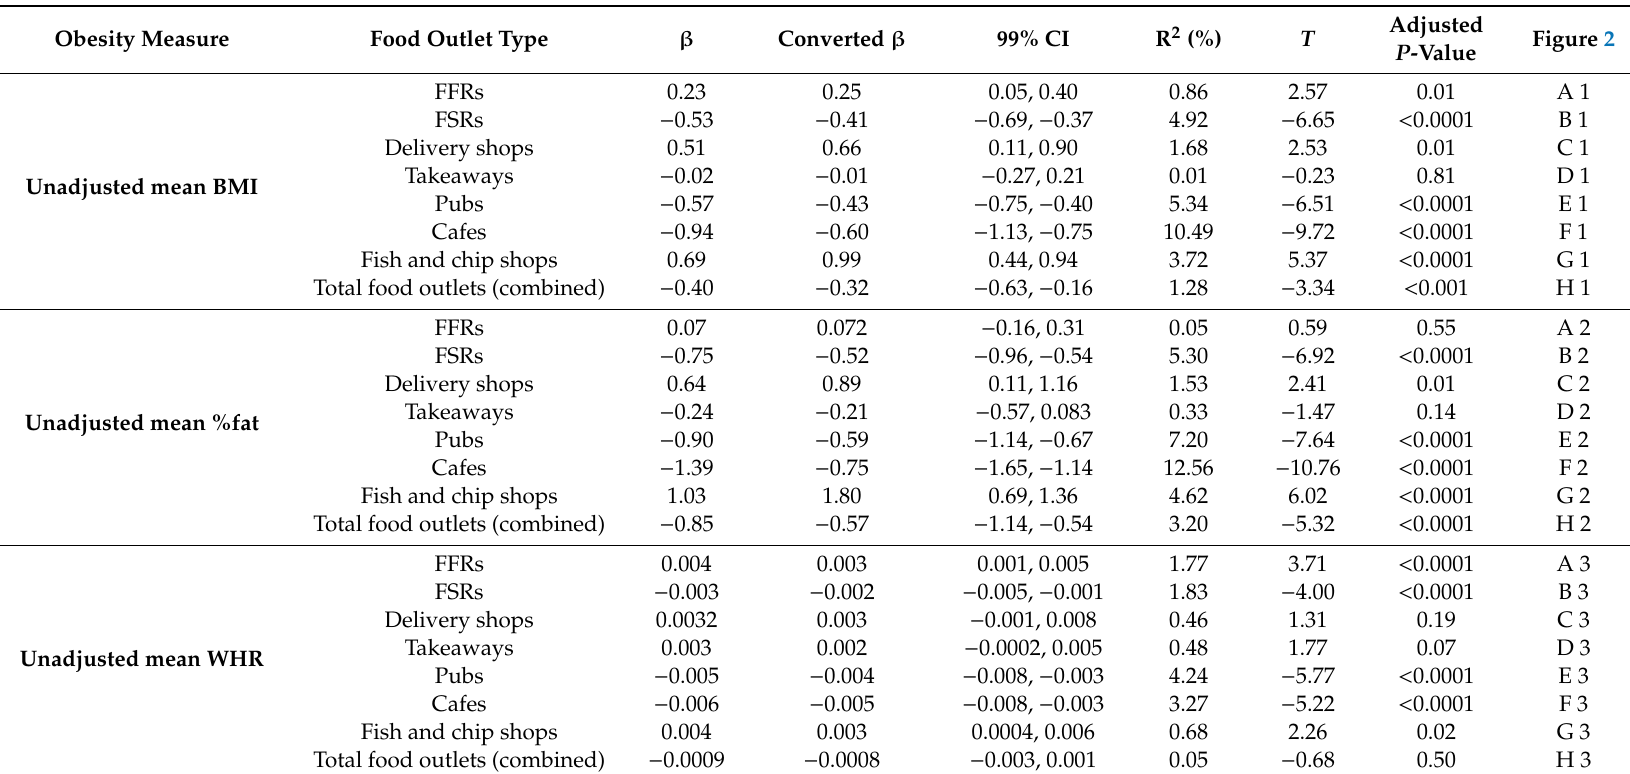
Table 5. Females: Linear regression analysis of the association between log-transformed numbers of food outlets per 1000 population and unadjusted obesity measures. Obesity Measure Food Outlet Type β